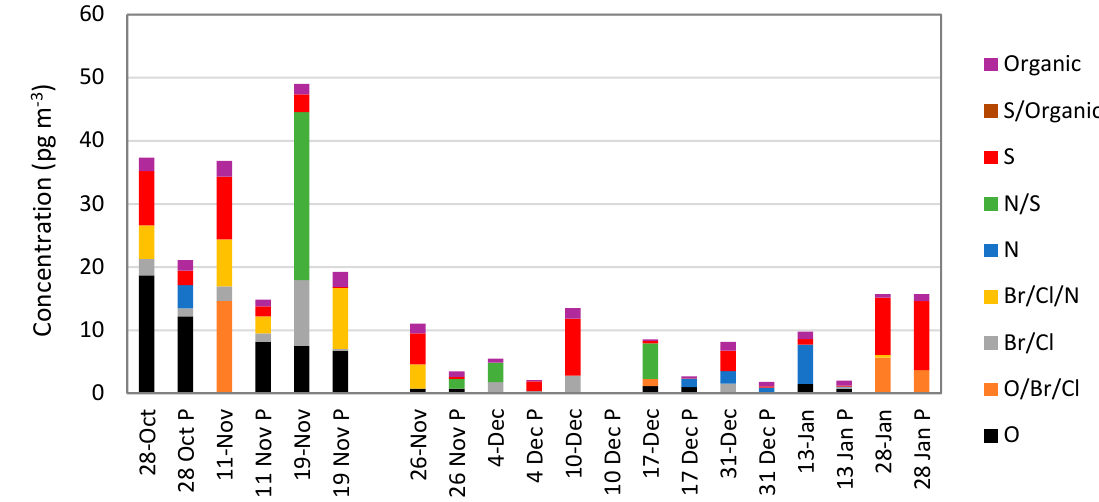
Figure 3. RM concentration data collected using Tekran system and RMAS 2.0 membranes (CEM and